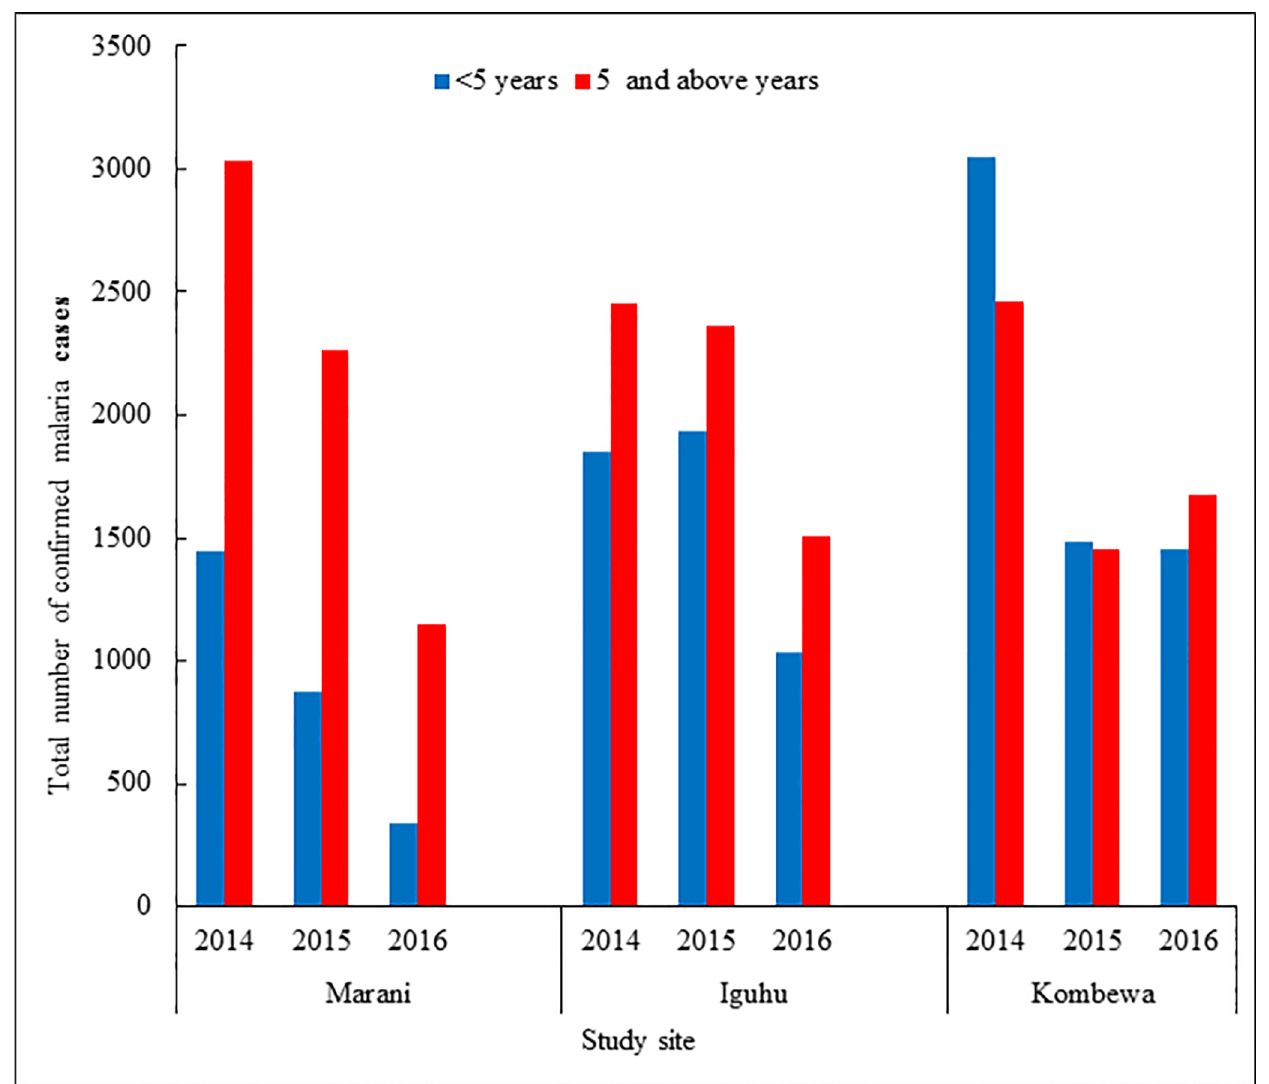
Fig 5. Trend of confirmed outpatient department malaria cases from 2014 through 2016 from three Hospitals in Western Kenya before and after LLINs mass distribution.